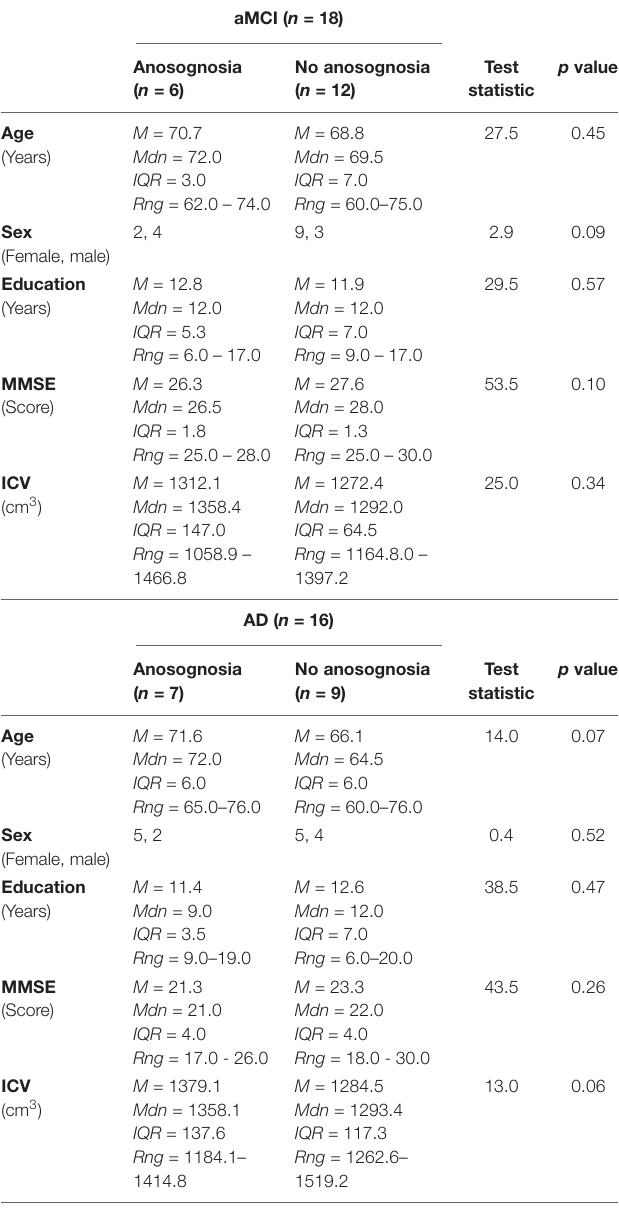
TABLE 2 | Demographic and clinical characteristics of patients with aMCI and AD displaying and not displaying